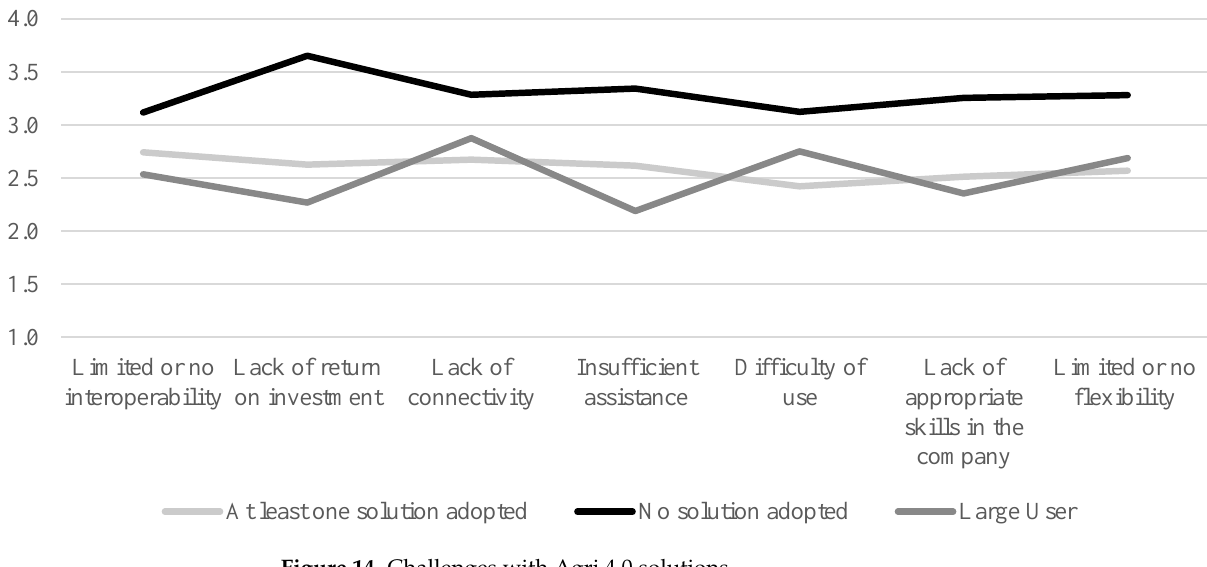
Table 13. Relative position of challenges.